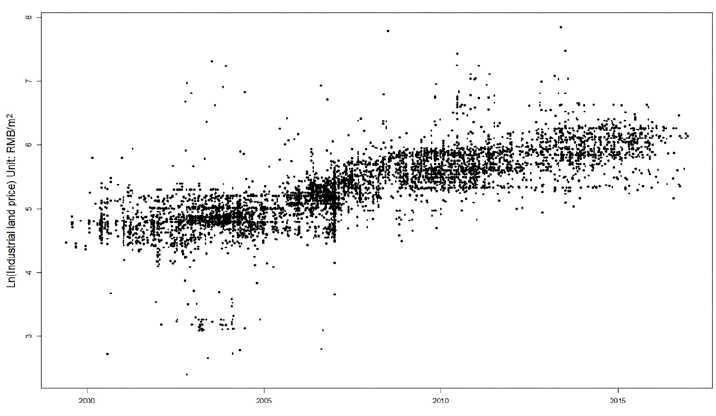
Figure 5. Scatter plot of transferred industrial land prices from 1999 to